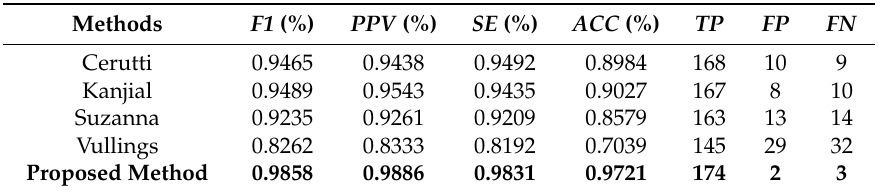
Figure 7. A segment performance using DB2 of our proposed method and other four typical single-channel methods with same preprocessed (low cutoff frequency f b = 7 Hz and high cutoff frequency f h = 100 Hz). Table 3. FECG QRS detected from statistical assessment of